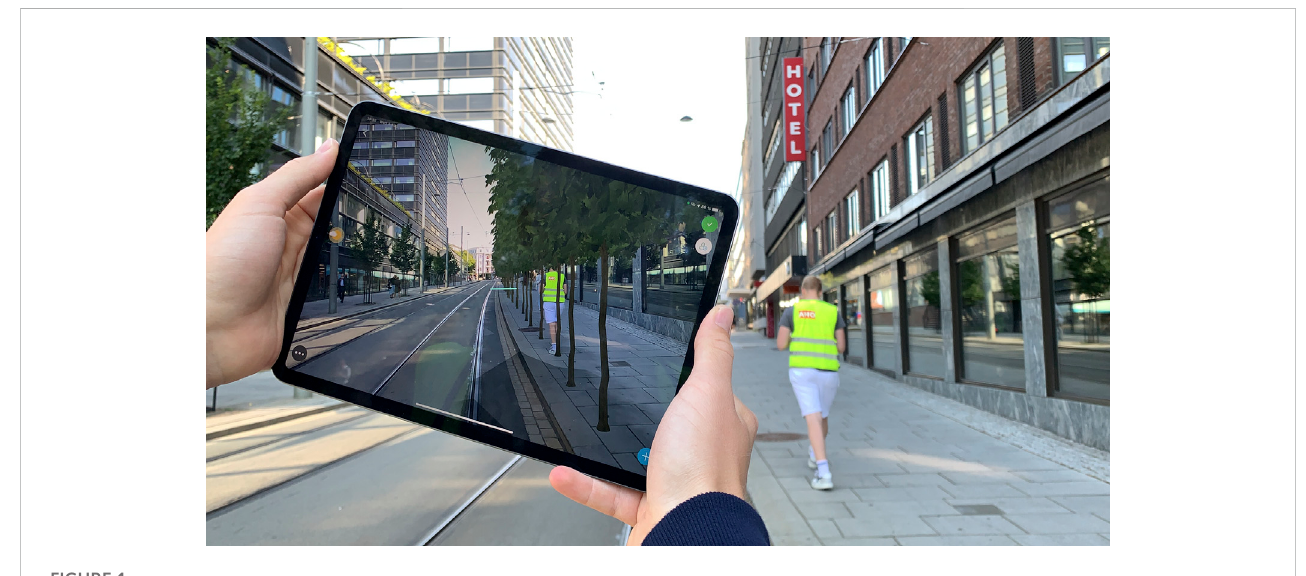
FIGURE 1 Youth participant places trees on site in Oslo through AR.